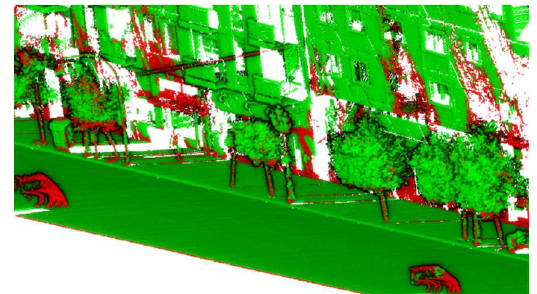
Figure 8: Point cloud coloured by correct semantic segmentation for 3 classes, 500 hidden layers and unweighted. Correct segmented classified point in green and misclassified in red.